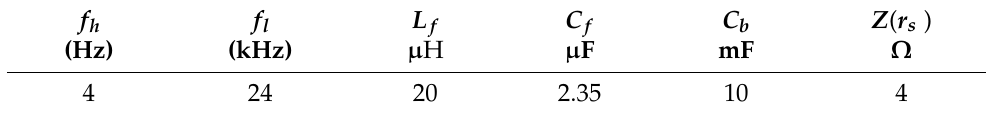
Table 1. f h , f l and component values of BPF